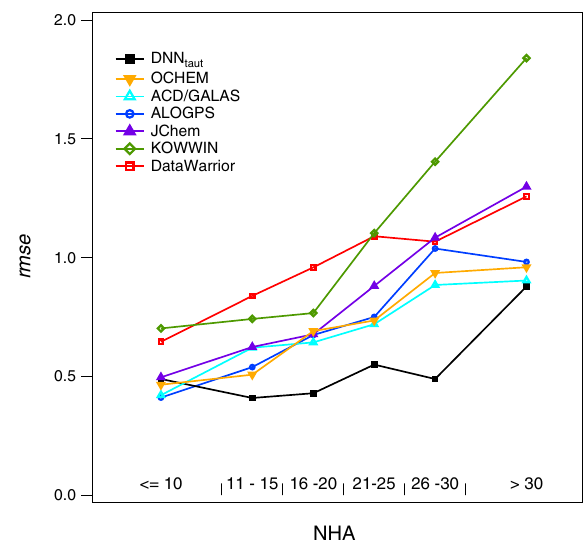
Fig. 3 Predictions of log P values for the test set by our DNN taut and six selected tools. The test set is represented by randomly selected SMILES codes including tautomers. The rmse values are shown for the range of non- hydrogen atoms NHA re fl ecting the size of the